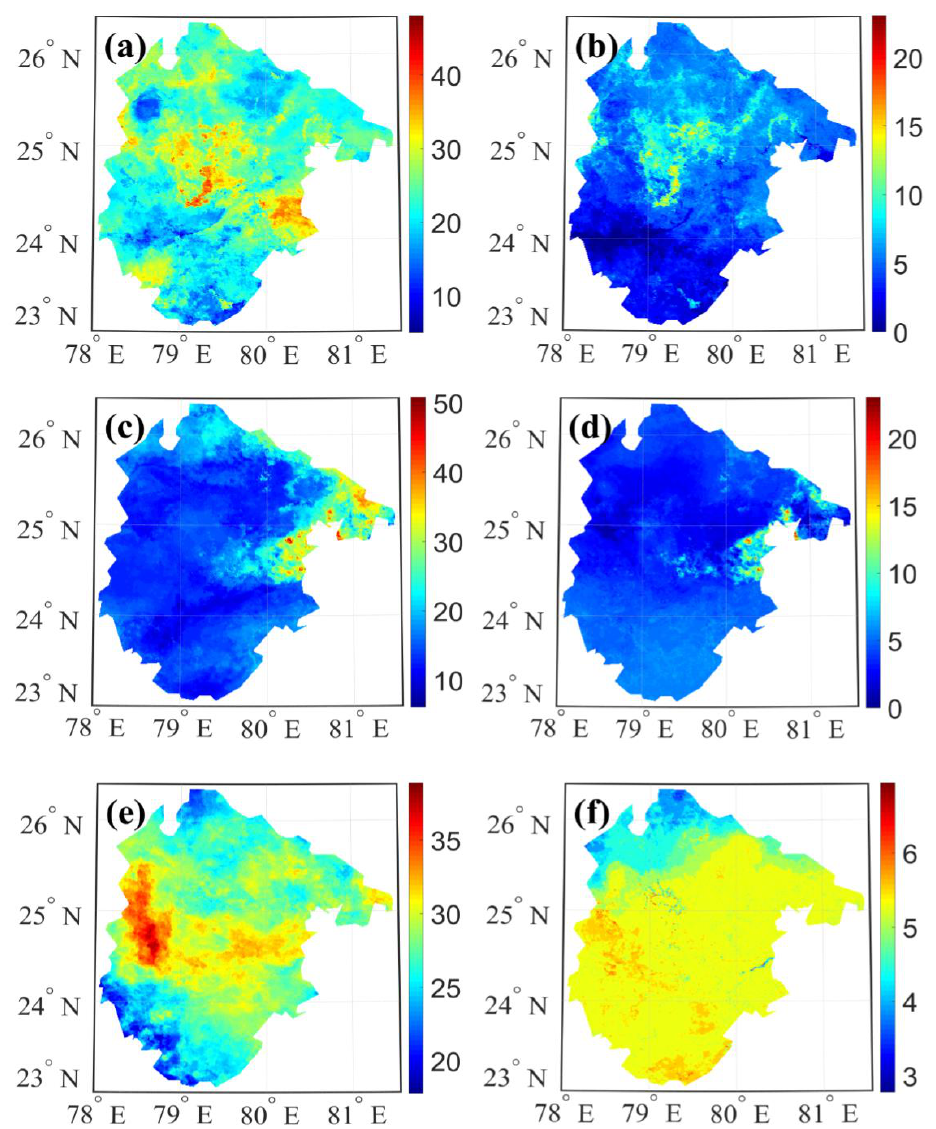
Figure 8. Drought duration maps for CMIP6 scenarios for study area BK. ( a , b ) for SSP1-2.6; ( c , d ) for SSP2-4.5; ( e , f ) for SSP5-8.5. ( a , c , e ) for severe drought and ( b , d , f ) for extreme drought. The scale bar represents months of drought in 30 years (2015 – 2044).